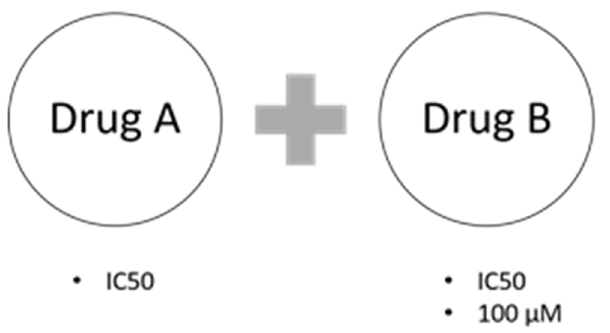
Figure 22. Schematic representation of the combination model used to assess the efficacies of paclitaxel (Drug A) and the repurposed drugs tested (Drug B).